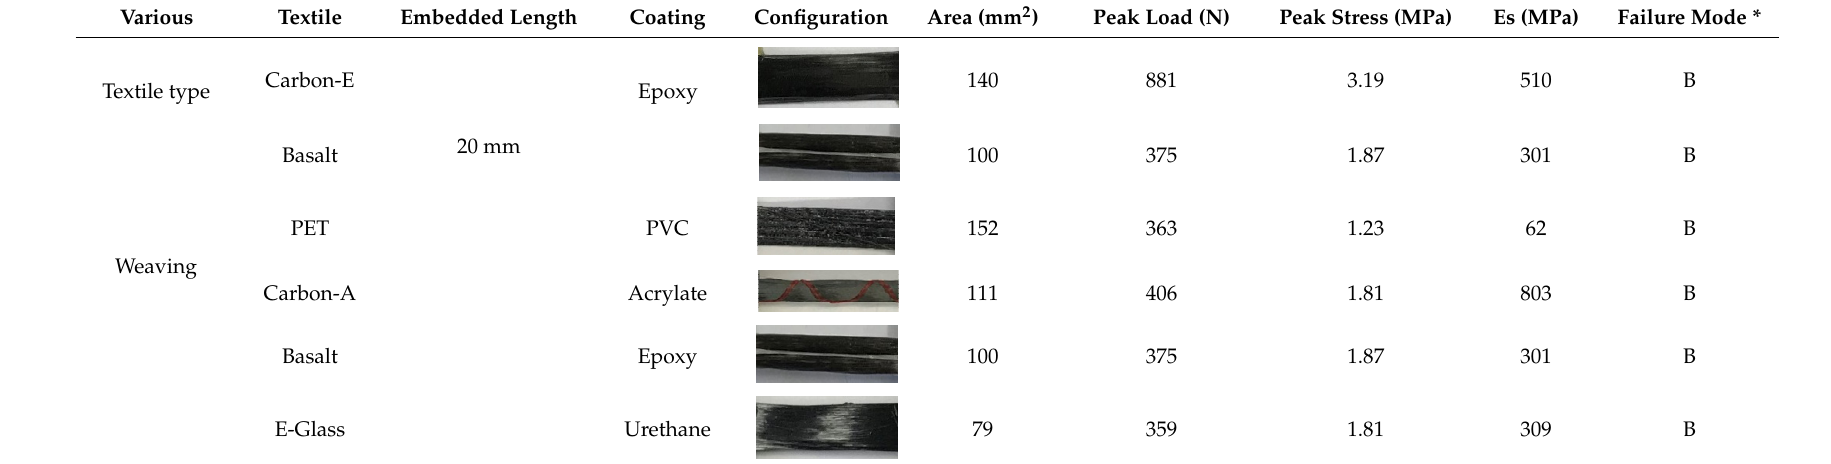
Table 6. Properties of pull-out specimens and test